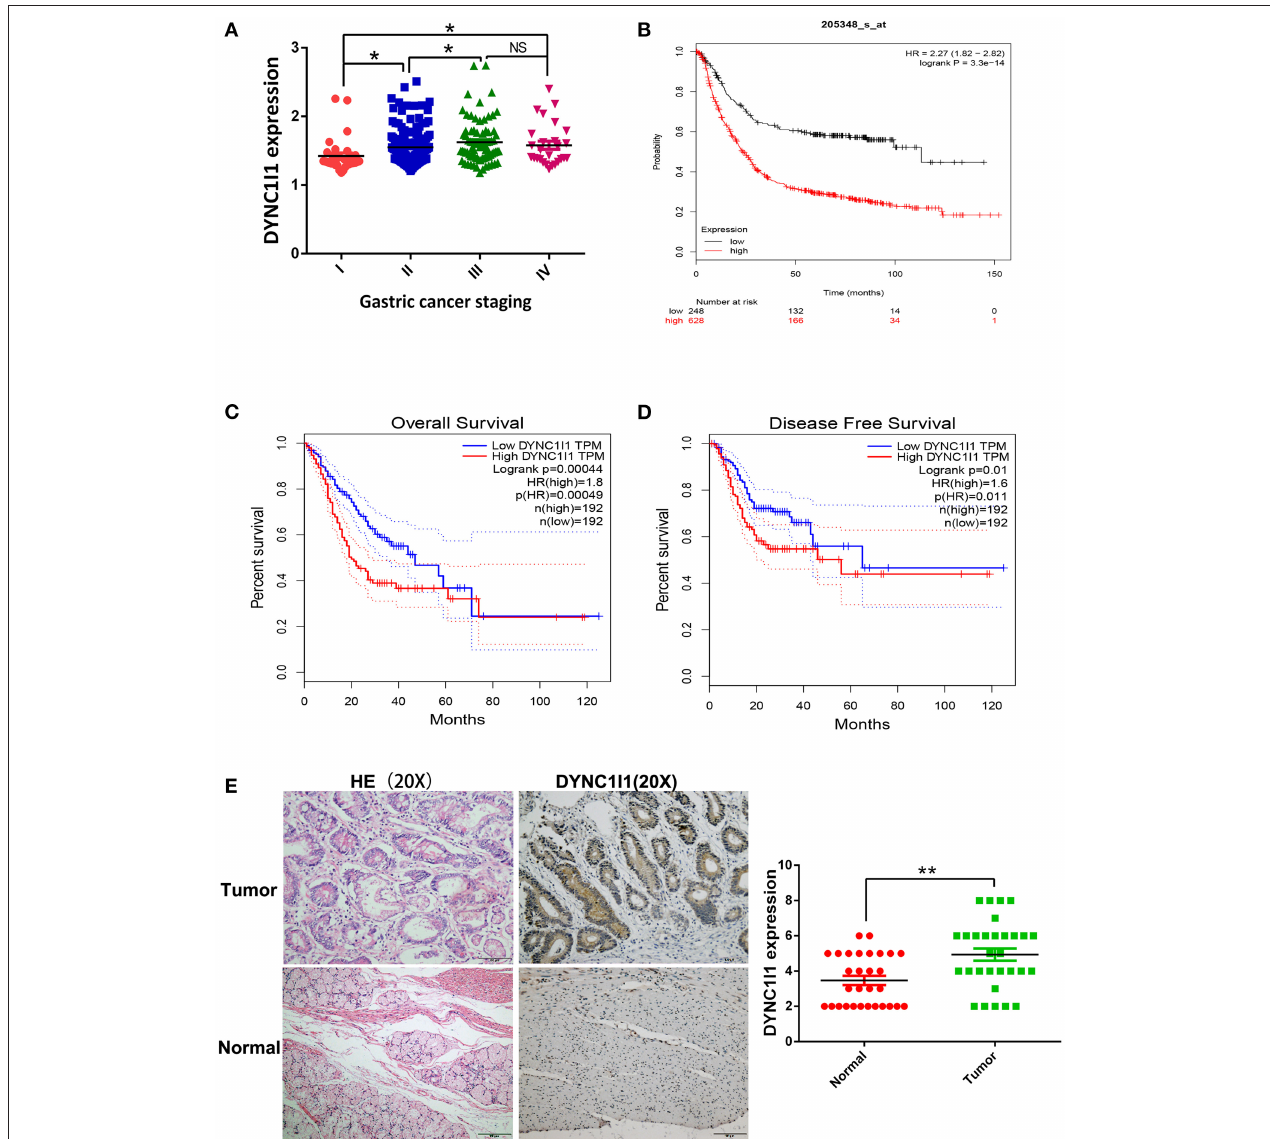
FIGURE 1 | High DYNC1I1 expression predicts poor prognosis in patients with gastric cancer. (A) Analysis of the relationship between the expression of DYNC1I1 and the staging of gastric cancer by GSE62254 gastric cancer dataset. (B) Kmplot analysis of DYNC1I1 expression and survival of gastric cancer patients. (C) COX analysis of DYNC1I1 and gastric cancer OS on the GEPIA website. (D) COX analysis of DYNC1I1 and gastric cancer DDFS on the GEPIA website. (E) The expression levels of DYNC1I1 in 30 pairs of GC tissues and the adjacent gastric cancer tissue, measured by IHC. The left were the HE stained sections, magnification × 100; and IHC-stained sections, magnification × 100; (* P < 0.05, ** P <